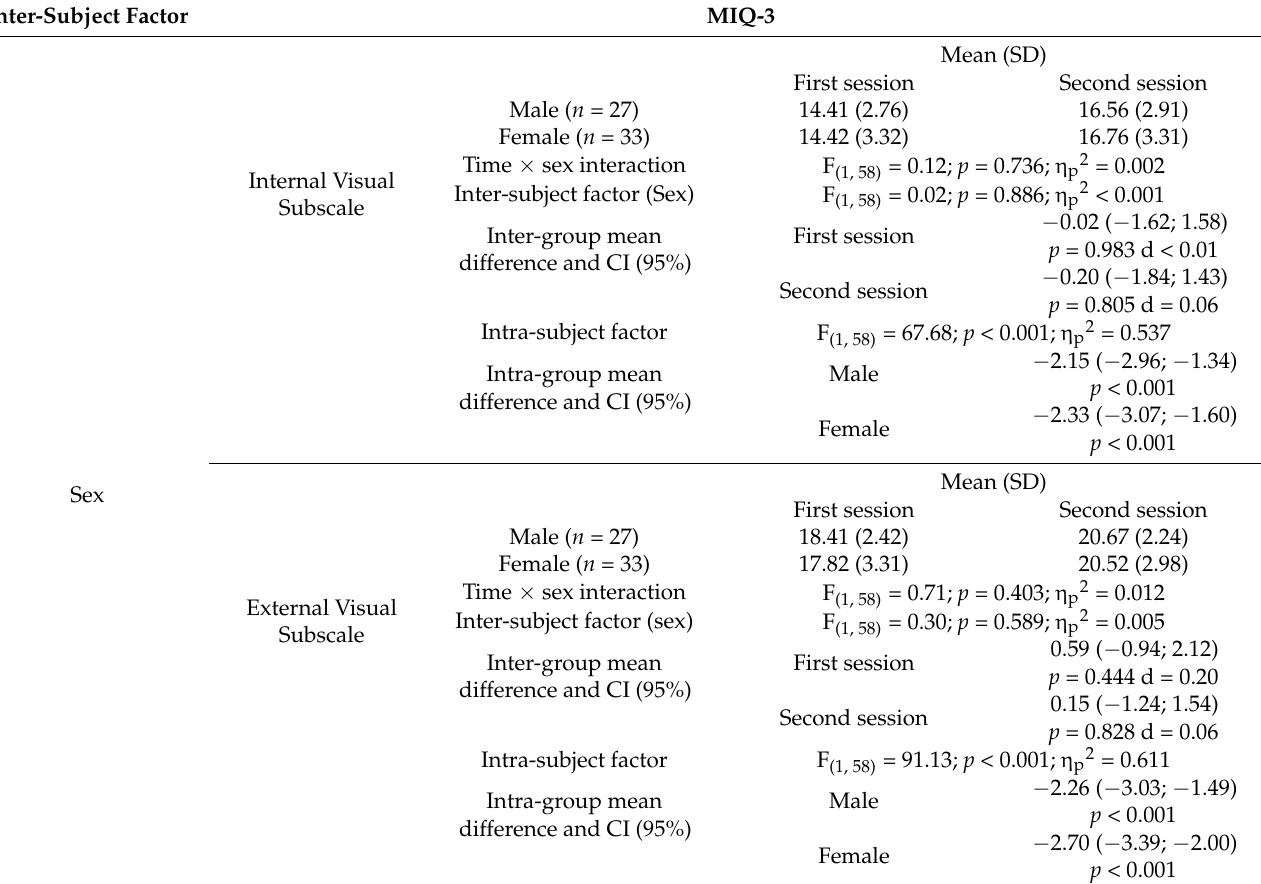
Table 4. The mixed factorial analysis of variance (ANOVA) results of the differences in motor imagery (MI) ability measured through the MIQ-3, according to sex.